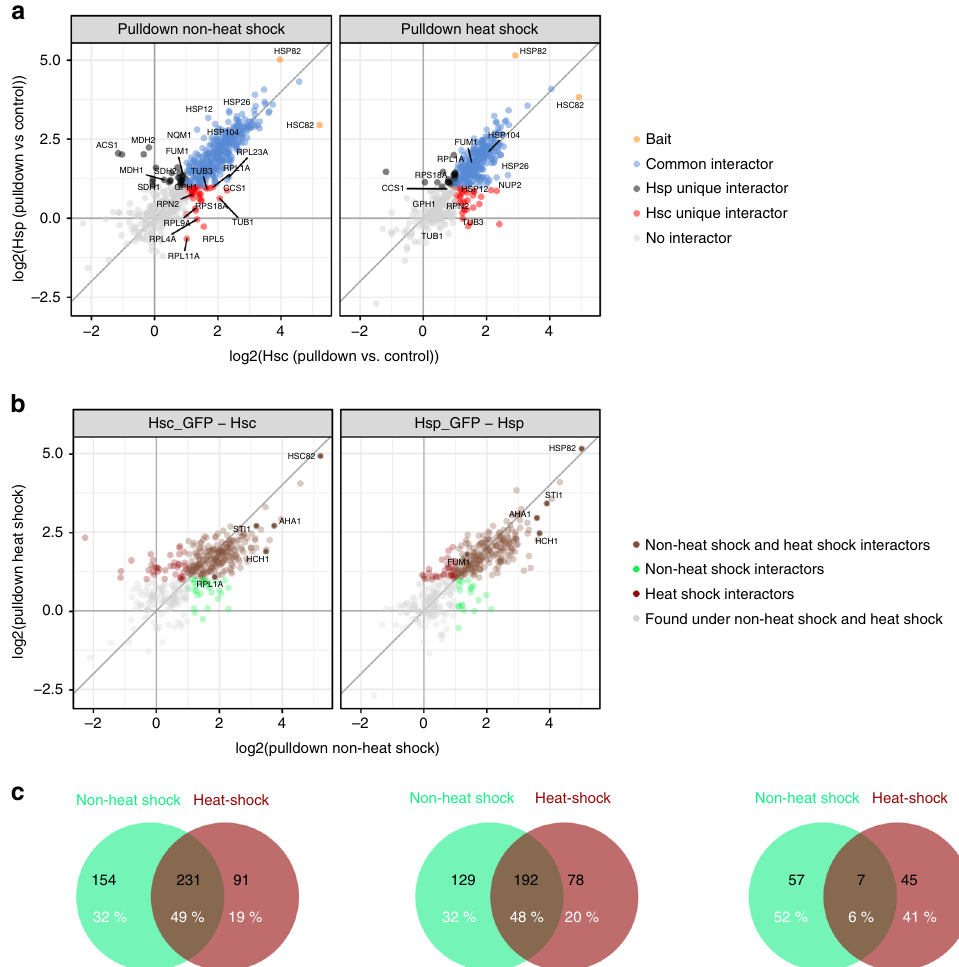
Fig. 6 Interactors of the yeast Hsp90 isoforms. a Correlation plot of enrichments ratios (pulldown against control) of Hsc-GFP versus Hsp-GFP. Proteins that were signi fi cantly enriched (log2 FC ≥ 1, fdr ≤ 0.05) in the pulldowns of both isoforms are categorized as “ common interactors ” . Proteins that were only signi fi cantly enriched (same criteria for enrichment as above) in the pulldown of a single isoform were categorized as Hsp unique or Hsc unique, respectively. b Correlation of interactors under non-heat shock and heat shock conditions. Proteins that were only signi fi cantly enriched in the non-heat shock sample (termed non-heat shock interactors) or the heat shock sample (heat-shock interactors) and those that were signi fi cantly enriched in both samples are displayed in different colors. Criteria for signi fi cant enrichment were the same as in Fig. 6a. c Venn diagrams displaying the overlap of